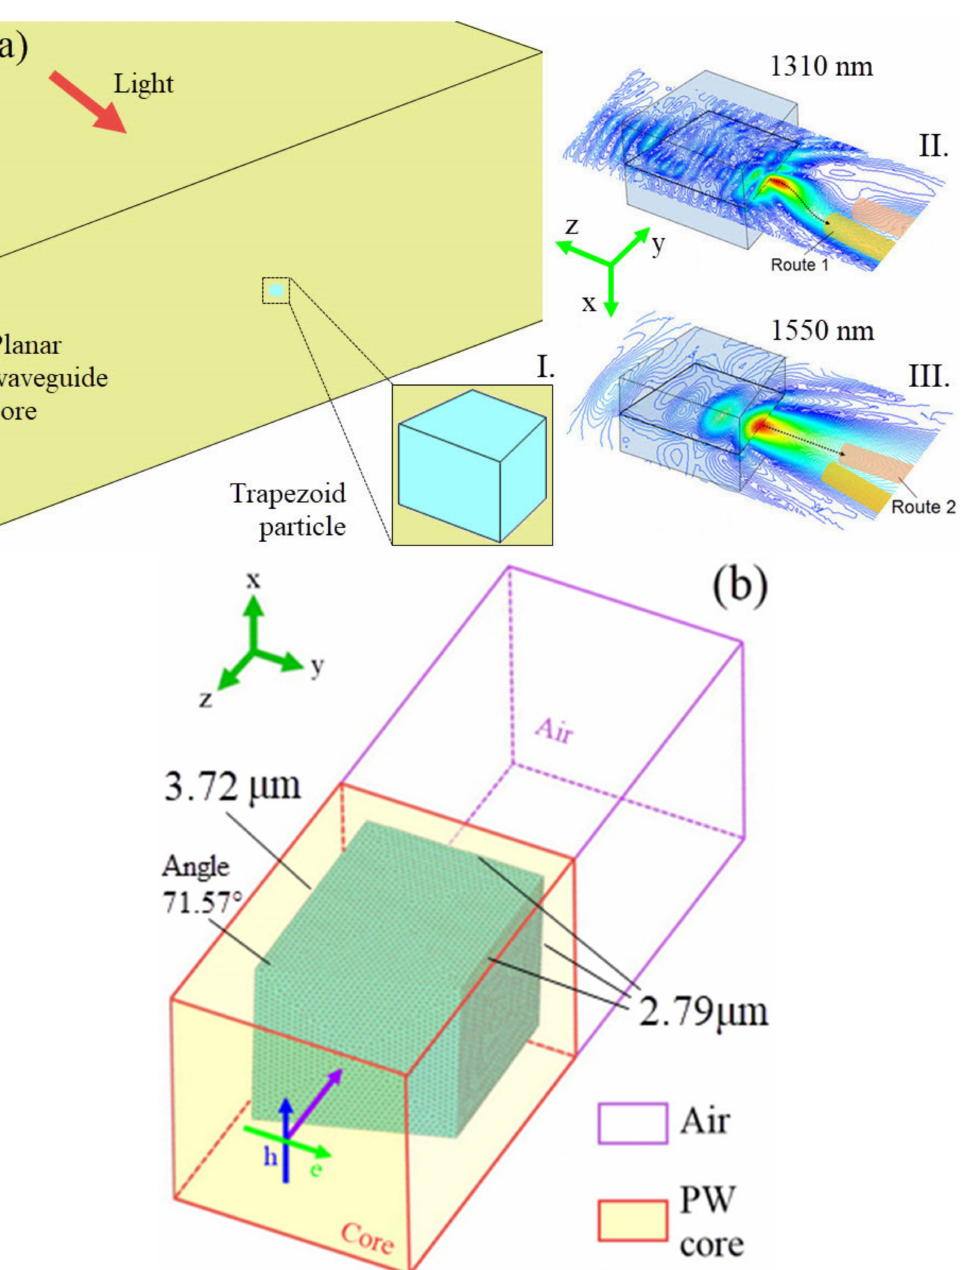
Figure 1. ( a ) I, diagram of photonic switch design; II and III, principle of the proposed photonic switching at two different wavelengths ( b ) CST modelling